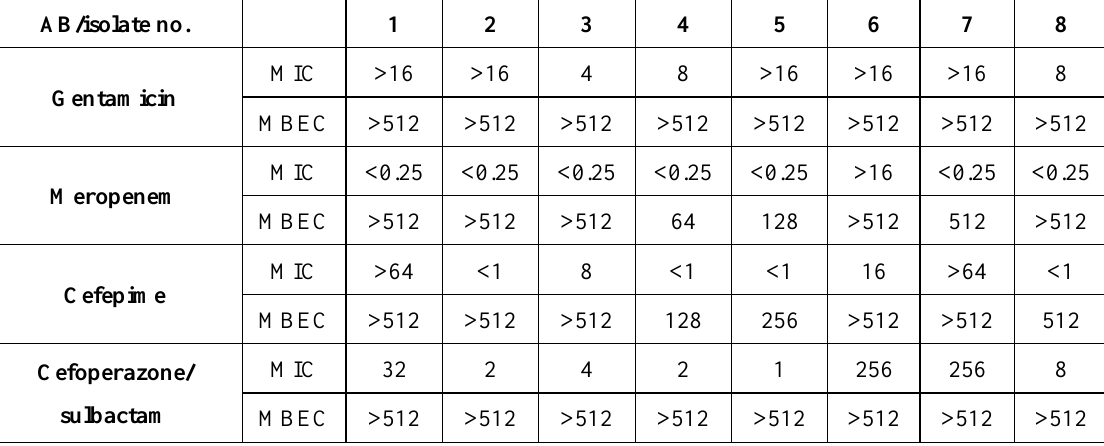
Table 1. Comparison between MIC and MBEC values for each Proteus biofilm forming isolate (n=8) . AB/isolate no.